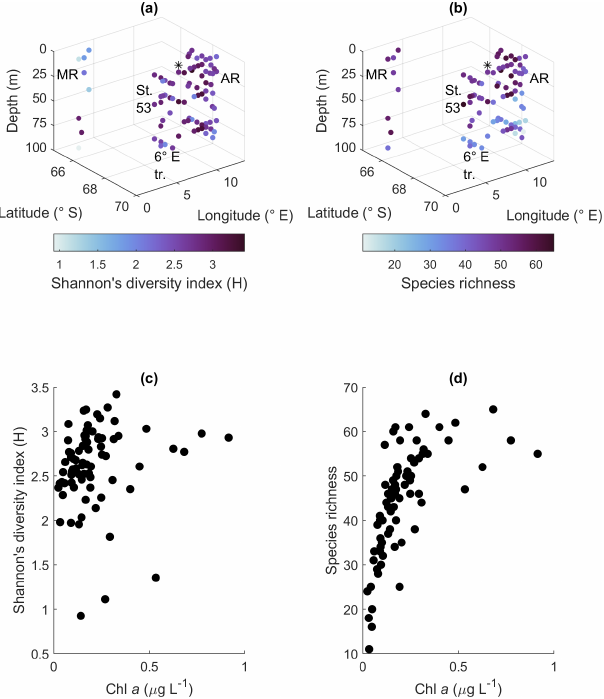
Figure 5. Biodiversity according to the microscopy samples. (a) Shannon’s diversity index, (b) species richness, (c) relation- ship between algal biomass (expressed in Chl- a concentration) and Shannon’s diversity index and (d) algal biomass and species rich- ness. MR: Maud Rise, St. 53: station 53, AR: Astrid Ridge, 6 ◦ E tr.: 6 ◦ E transect. Station 54 is marked with a black